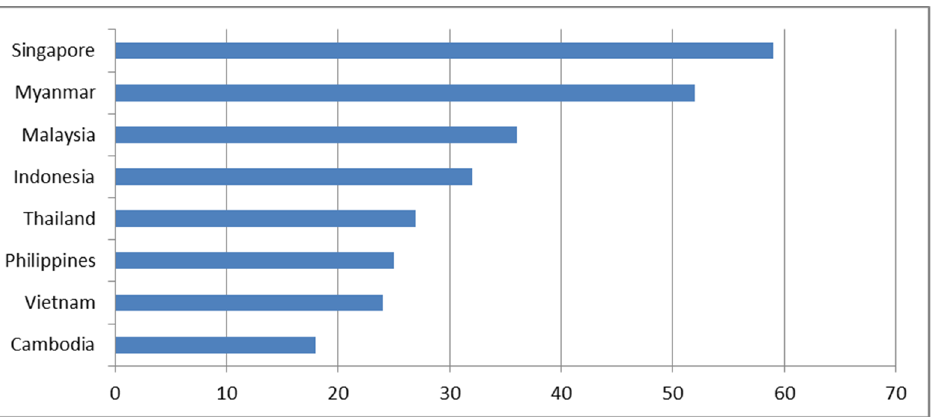
Figure 2. Adult financial literacy by country in ASEAN (%). Source: Klapper et al. (2015). Financial literacy shows inverse correlation with the unbanked population. The higher the financial literacy of the people, the lower would be the country’s unbanked population. For instance, Vietnam, with a relatively low level of financial literacy (24%), has a high rate of unbanked population (69%). Additionally, Klapper et al. (2013) explain individuals with higher levels of financial knowledge experience lower negative impacts during a global financial crisis than a financially illiterate person. New evidence from Anand et al. (2020) also reveals that financial literacy knowledge plays a pivotal role in managing personal finance when facing the COVID-19 outbreak. In other words, a fi- nancially literate person would be more resilient during challenging economic situa- tions.